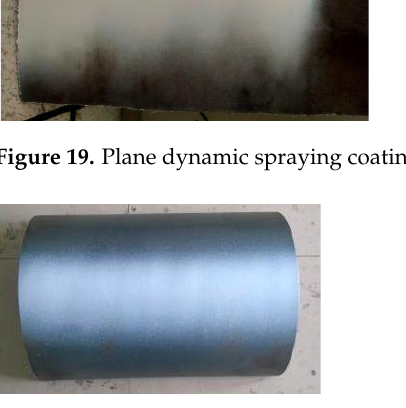
Figure 20. Dynamic spraying coating film distribution.